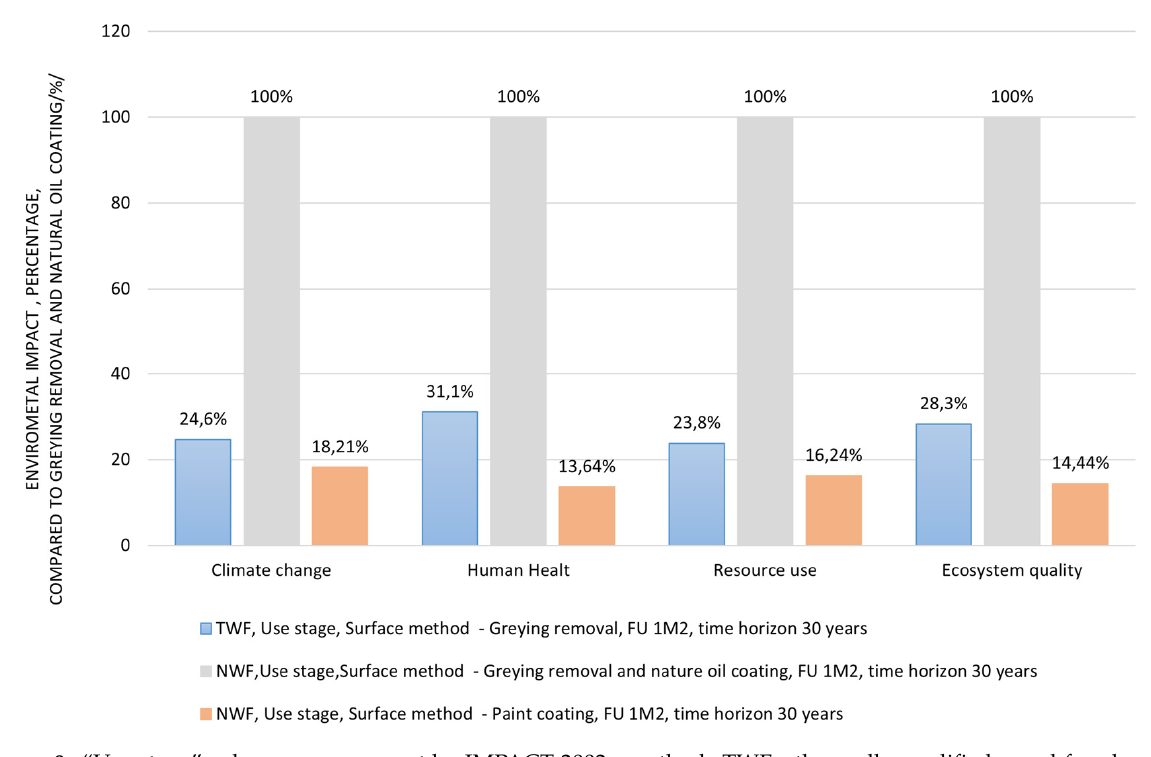
Figure 9. “Use stage”—damage assessment by IMPACT 2002+ method. TWF—thermally modified wood façade with selected surface method, NWF—non-heat-treated wood façade with selected surface methods. Comparing FU 1 m 2 of TWF and NWF, Use stage, time horizon 30 years.